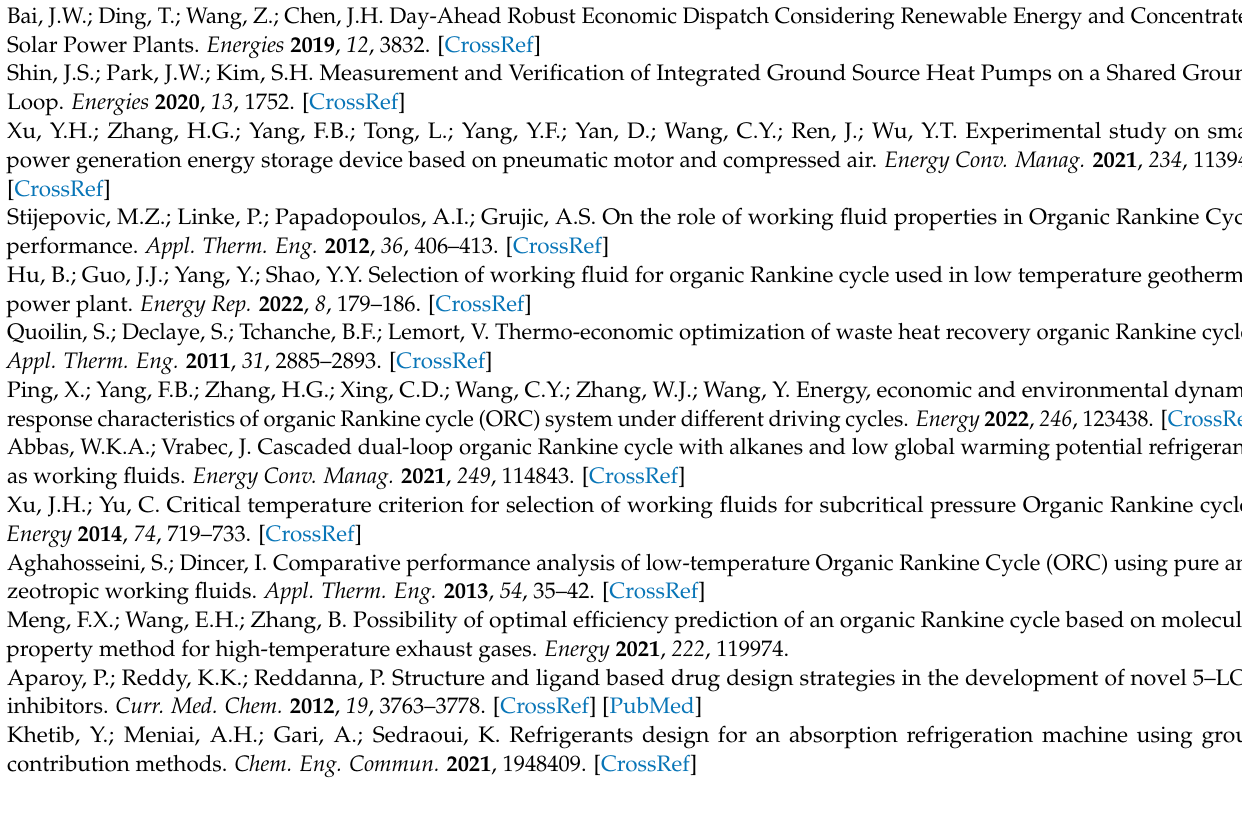
Figure A3. Comparison of